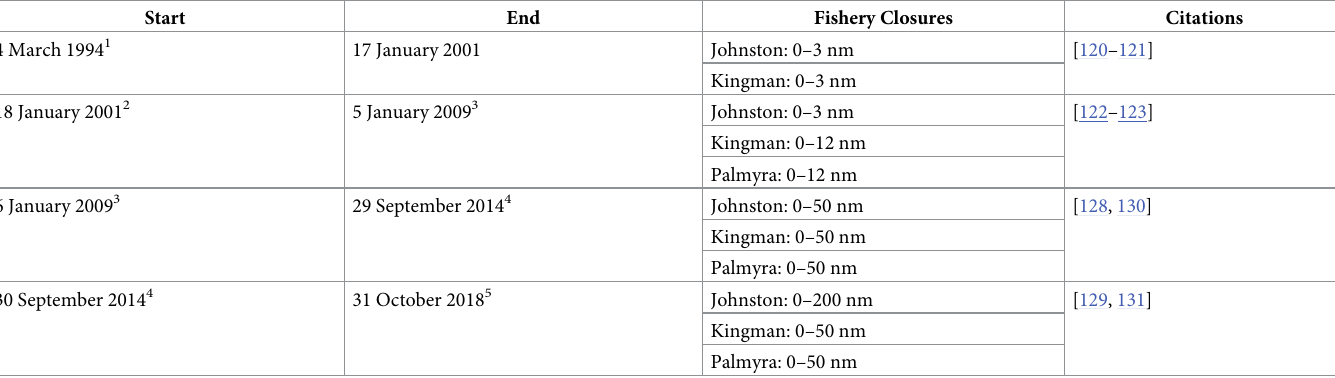
Table 3. Dates of area-based fishery closures within the US EEZ adjacent to Johnston Atoll, Kingman Reef and Palmyra Atoll during the study period. Start